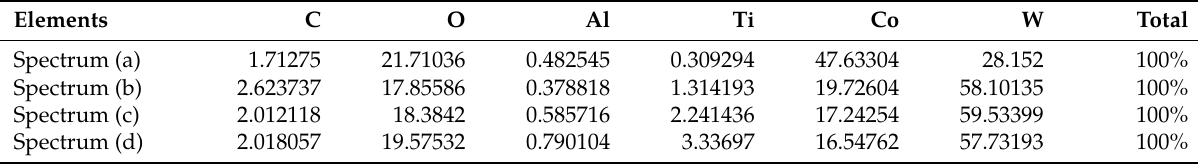
Table 6: Different elements of the spectra (a – d) SEM/EDS in different points of the used track for temperature P2(650°C). Elements C O Al Ti Co W Total Spectrum